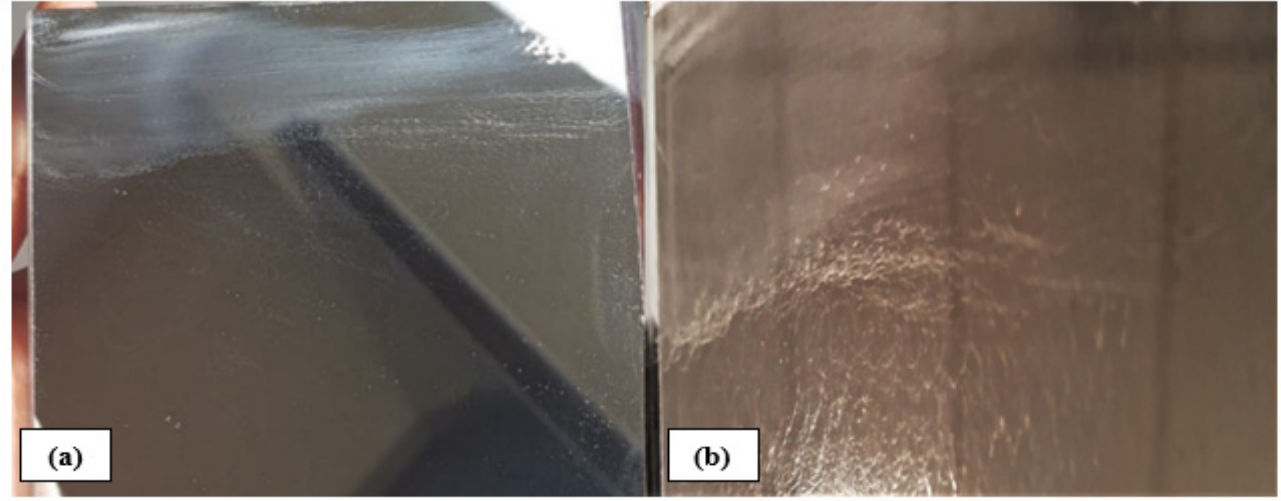
Figure 12. Pictures of detected defects on; ( a ) uncoated and ( b ) coated samples after 170 h of SUNTEST test N°2.